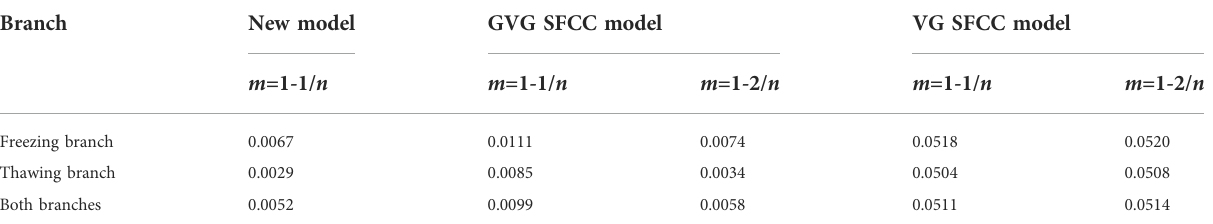
TABLE 3 RMSE for different SFCC models.